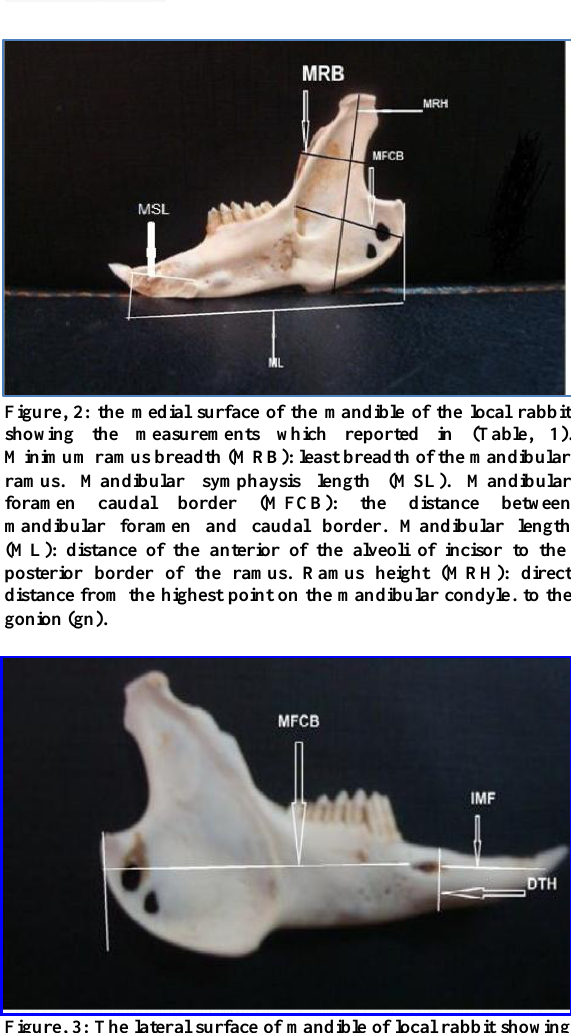
Figure, 1: The mandible bone of the local rabbit showing the measurements which reported in (Table, 1). (f): retroalevolar foramen. Gonion (GN) a point along the rounded postero-inferior corner of the mandible between the ramus and the body. Gondylion (CD): the most lateral point on mandibular condoyle (paired). Breadth of the mandibular body: (BMB) maximum breadth measured in the region of the mental foramen. Bigonial width (BW): direct distance between right and left gonion (gn). Bicondylar breadth (BCB): direct distance between the most lateral points on the two condyles (CD). Distemal length (DL): distance between the incisors to the first molar. Length of cheek teeth row (LCHR).